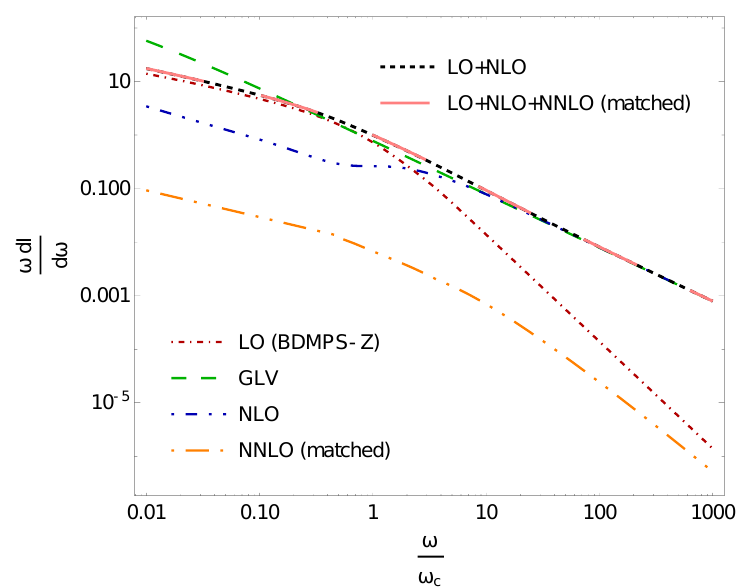
Figure 4 . The analogous plot to (cid:12)gure 2, but now extended to a larger frequency domain. In addition, we also include the spectrum up to NLO (black line) and NNLO (pink line) accuracy. All the curves are the same as in the previous plot, except the NNLO solution which is obtained by matching the scaling as ! ! 0 at a frequency cut o(cid:11) ! cut = 0 : 5 (cid:2) ! c , after which the solution is obtained by using equation (3.6). The scaling for smaller frequencies is obtained by making use of equation (3.16) and the LO scaling law p ! c . This procedure is indicated by the matched tag. !